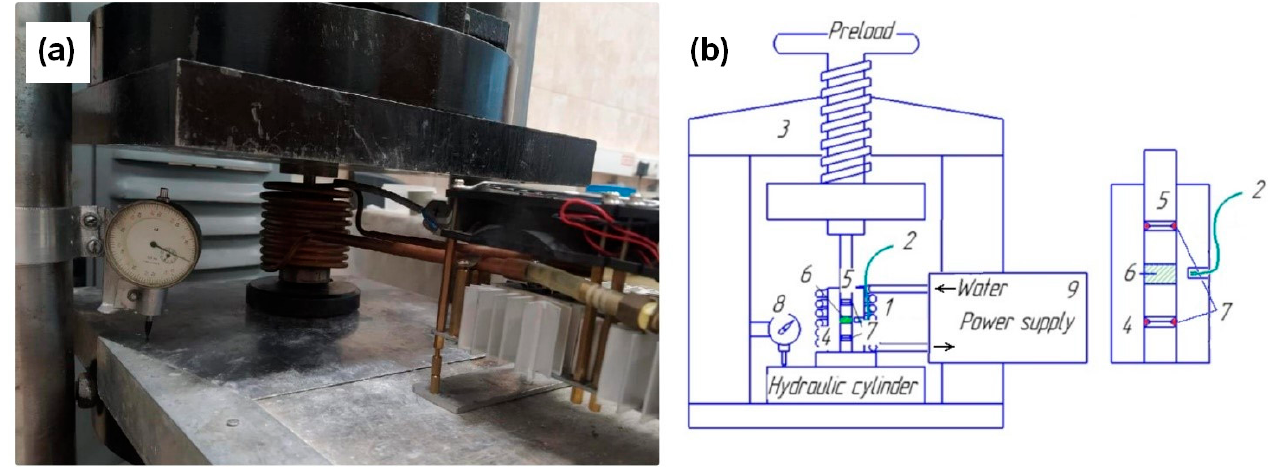
Figure 15. Equipment for cold sintering process ( a ) and its scheme ( b ): 1–induction heating; 2–thermocouple; 3–hydraulic press; 4–press form; 5–set of punches; 6–ZnO powder; 7–sealing; 8–sensor; 9–power supply.